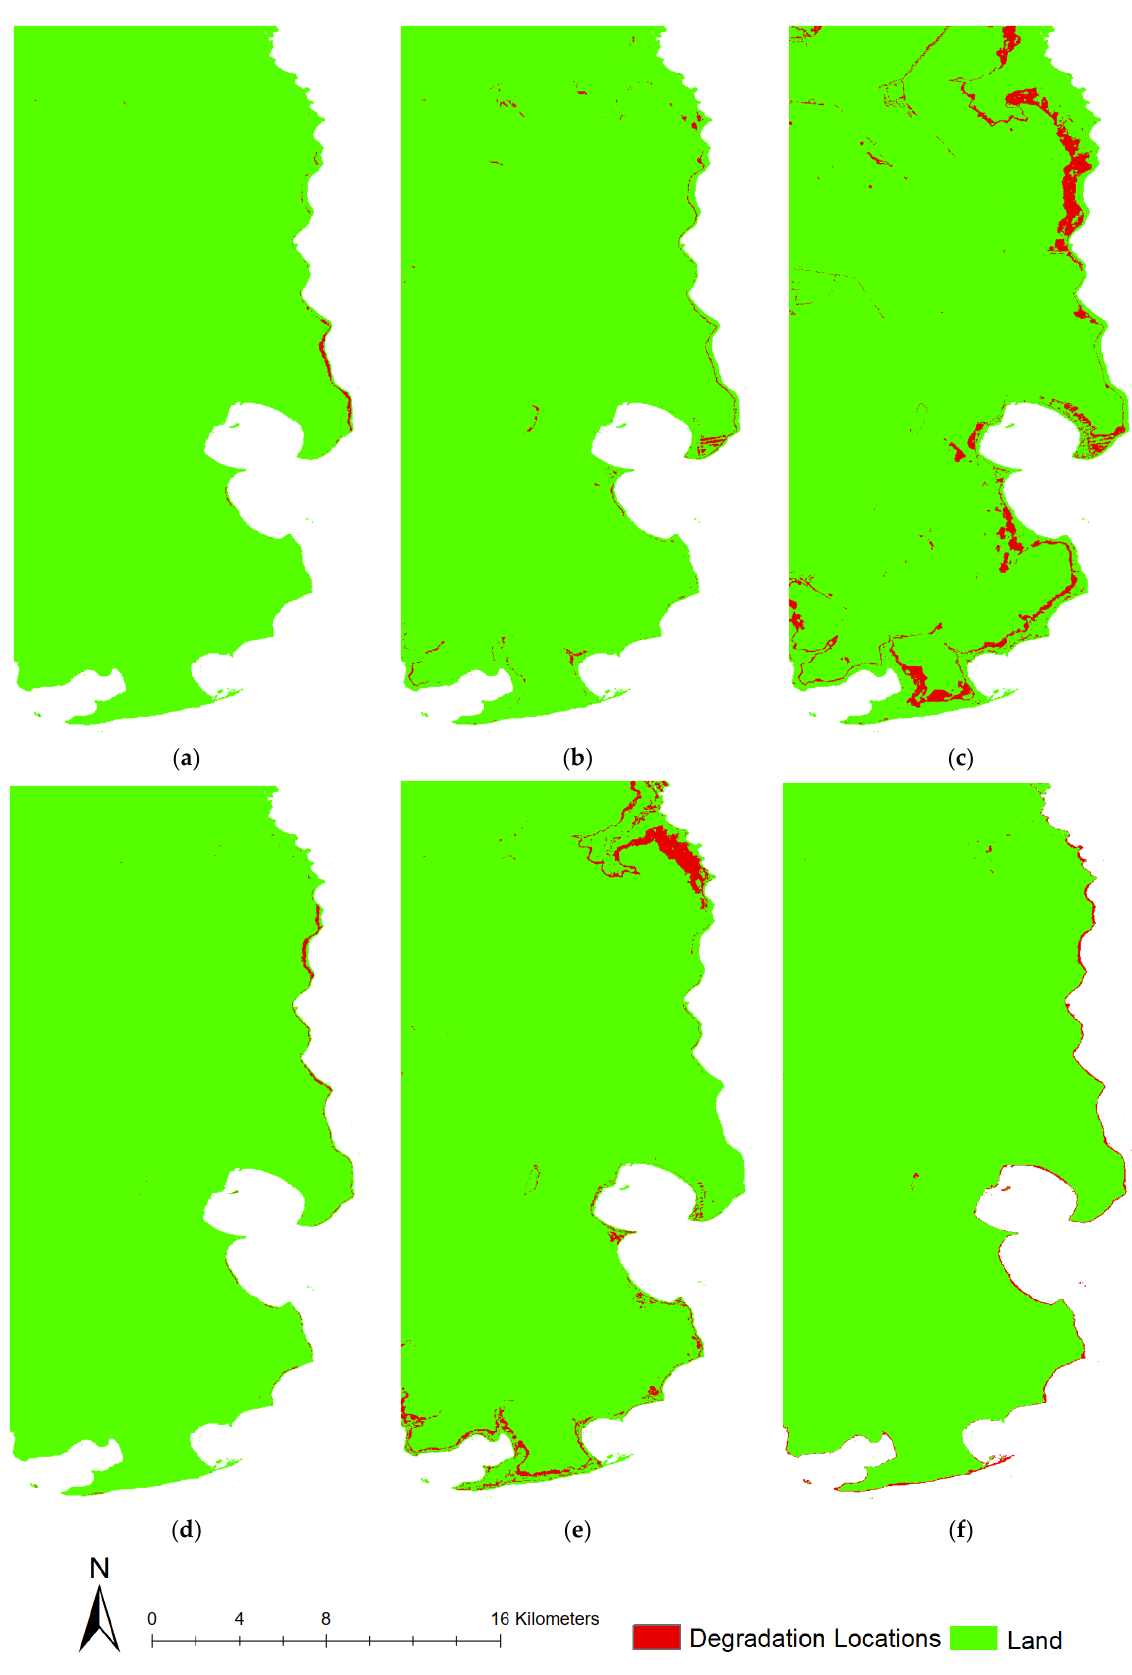
Figure 6. Detected wetland degradation locations over the ARNWR from 1995 to 2019. ( a ) Type 1 degradation: Forested wetlands degrading to non-vegetated areas; ( b ) Type 2 degradation: